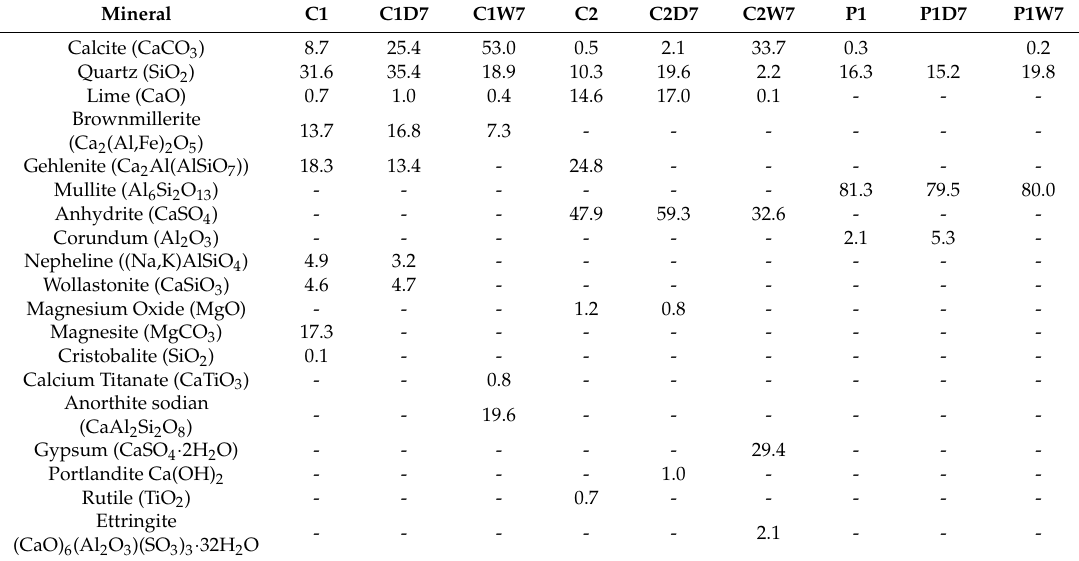
Table 3. XRD Rietveld refinement analysis of carbonated bottom